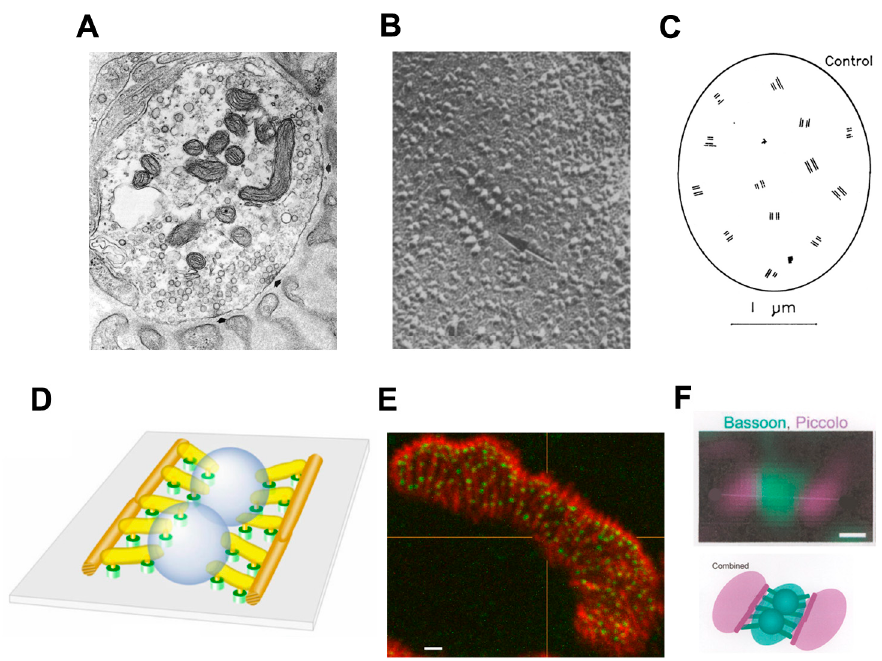
Figure 3. Vertebrate Active Zones (AZs). ( A ) EM image of terminal bouton, with prominent mitochondria and SVs. The arrowheads point to two AZs. Note the clusters of synaptic vesicles (SVs) around the AZs (indicated by arrows). (From Engel, 2004, with permission) [15]; ( B ) A mammalian AZ, indicated by arrow, visualized in a freeze-fracture replica. Note that characteristic double rows of intramembranous particles, believed to include the Ca v 2.2 channels. Scale bar, 0.5 μ m. (From Fukunaga et al., 1983, with permission) [16]; ( C ) Diagram of freeze-fracture replica of a nerve terminal bouton showing the distribution of AZs. Scale bar, 100 nm. (From Fukunaga et al., 1982, with permission) [13]; ( D ) Fine structure of mouse AZ determined by 3D electron microscope tomography. Note the numerous, regularly arranged structural components and the two SVs held in a central position. (From Nagwaney et al., 2009, with permission) [9]; ( E ) Fluorescence image of part of a mouse motor nerve terminal. AChRs (red, α -bungarotoxin), bassoon, a protein component of the AZ (anti-bassoon, green). Scale bar, 100 nm. (From Chen, 2012, with permission) [17]; ( F ) Images of bassoon (green) and piccolo (red) distribution at a single mouse AZ, recorded by STED microscopy. Below, representation of the STED labeling superimposed on a simplified rendition of the AZ structure as in ( D ). Scale bar, 50 nm. (From Nishimune et al., 2016) [11].